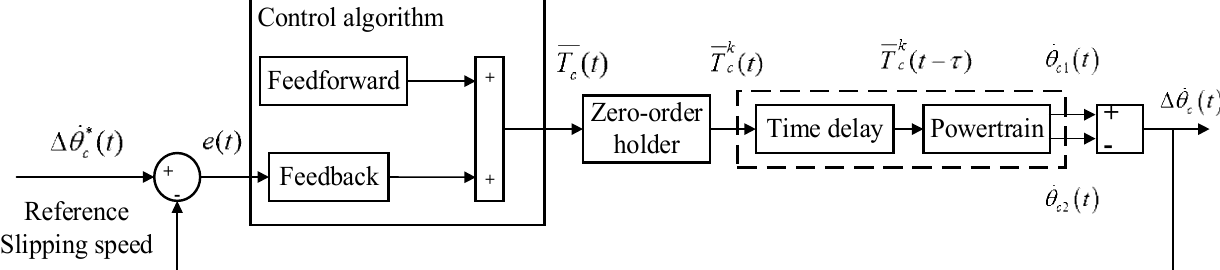
Figure 2. Diagram of closed-loop control system during clutch engagement.